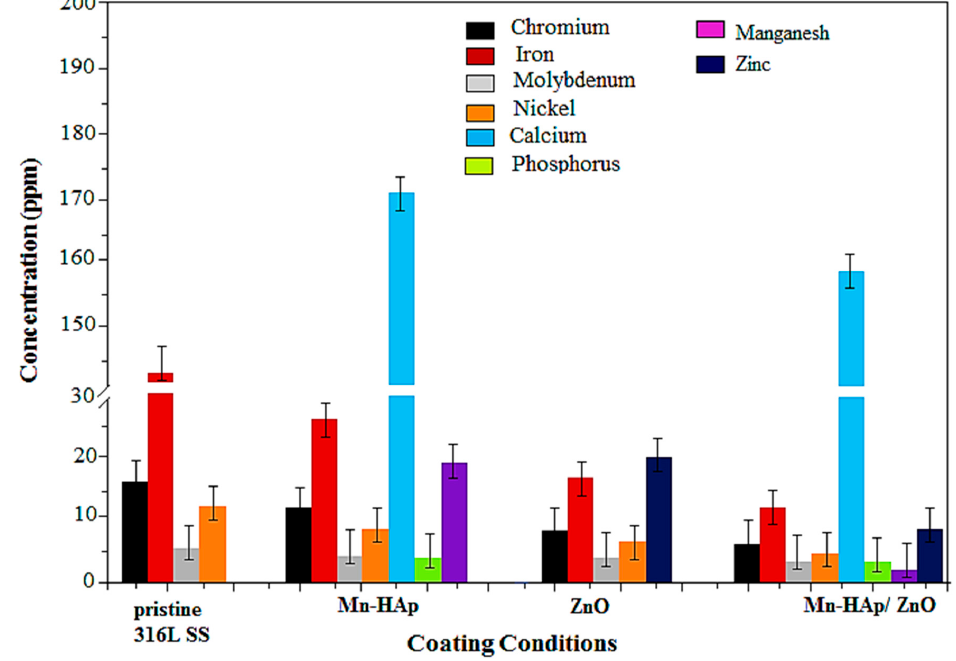
Figure 10. Leach-out analysis of pristine 316L SS, and Mn-HAp, ZnO, and Mn-HAp/ZnO bilayer coating on 316L SS. [The % error of the measured sample associated to the true value is determined by the following equation: % error = Absolute value [(true value-measured value)/true value] × 100. Acceptance criteria is a %RSD and a % Error less than 10%.].